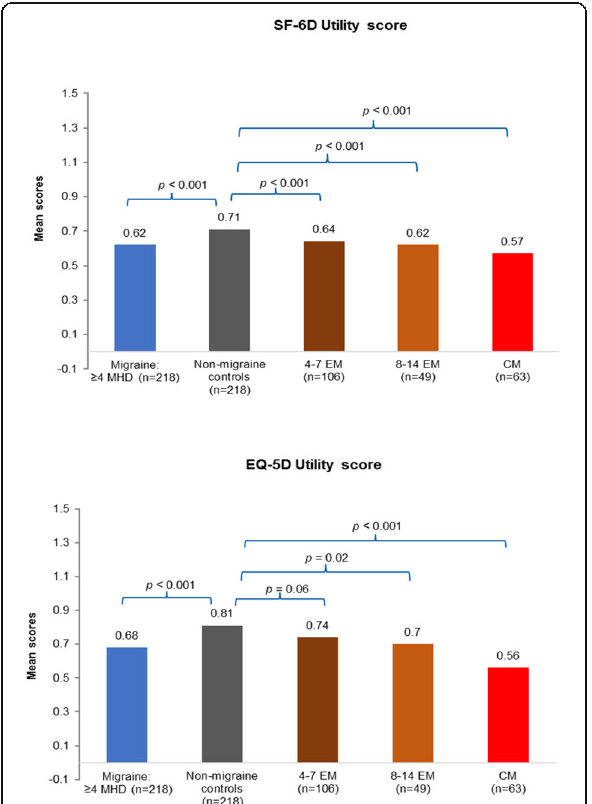
Fig. 3 SF-6D health utility score and EQ-5D Index of migraine subgroups vs propensity score matched non-migraine controlsT- tests were used for analysis.CM, chronic migraine; EM, episodic migraine; EQ-5D, EuroQol-5D; MHD, monthly headache day; QoL, quality of